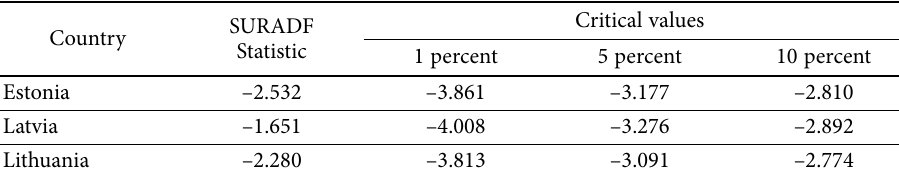
Table 2. SURADF test